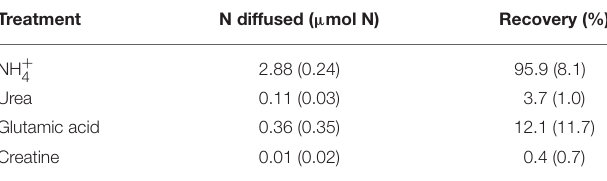
TABLE 3 | N recovered after the first step of the diffusion method for ammonium (NH + 4 ) and three organic molecules solutions.